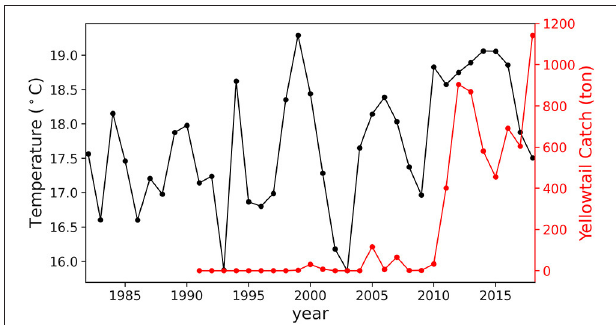
FIGURE 13 | Time series of the SST averaged over the black box of Figure 2 in JAS (black curve; ◦ C on the left axis; the same as Figure 1B ) and the time series of the catch of yellowtail (red curve; ton on the right axis) in southeastern Hokkaido (Hidaka, Tokachi, and Kushiro areas). The catch data is taken from Annual Statistics on Fishery and Aquaculture Production in Hokkaido (in Japanese) at: http://www.pref.hokkaido.lg.jp/sr/sum/03kanrig/sui-toukei/